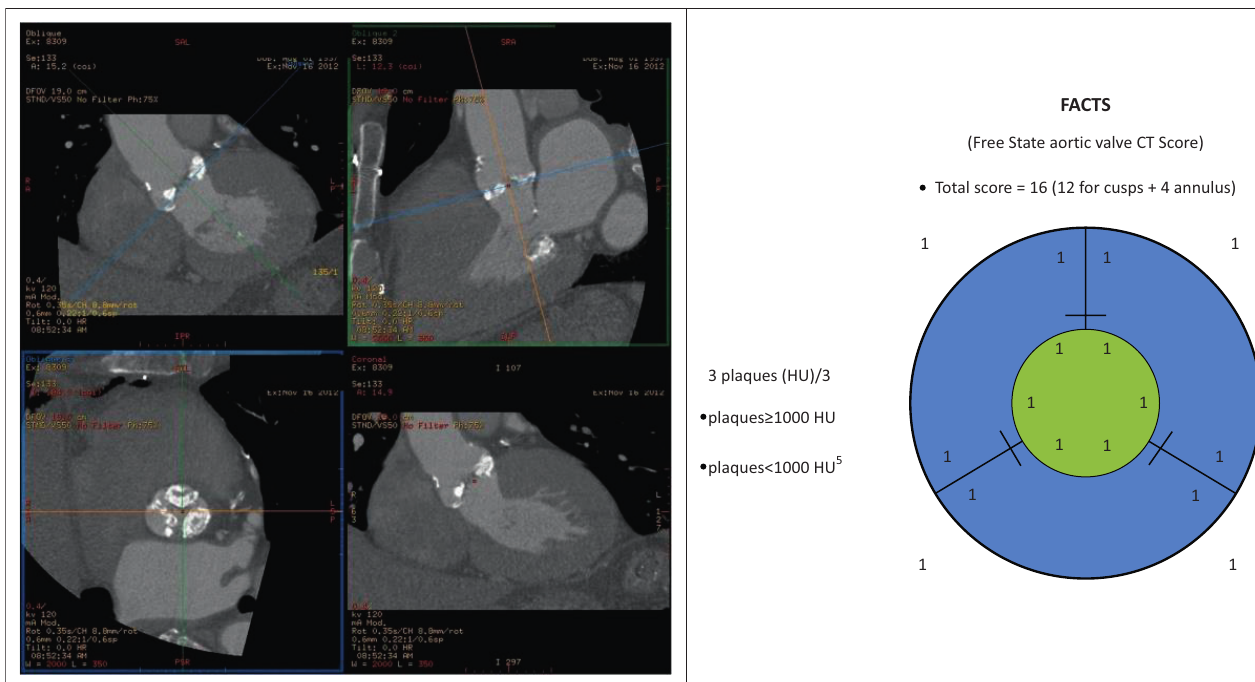
Source : Adapted from AVCS score where >750 HU had significant functional impairment,post procedural AR, increased 1-year mortality and procedural complications Leber AW, Kasel M, Ischiger T, et al. Aortic valve calcium score as a predictor for outcome afterTAVI using the Core Valve revalving system. Int J Cardiol. 2011. http://dx.doi.org/10.1016/j.ijcard.2011/ FIGURE 1: Schematic representation of the FACTS score average Hounsfield units (HU) score. Each number represents 25 % /1 point of the valve cusp = total score of 12. The outer numbers represent 25 % /1 point of the annulus. Total score of both aortic annulus and cusps therefore = 16. The most heavily calcified plaque on each cusp was measured in HU and divided by a factor of 3 to obtain an average score of either ≥1000 HU or <1000 HU). Annulus calcifications were not taken into account with the HU